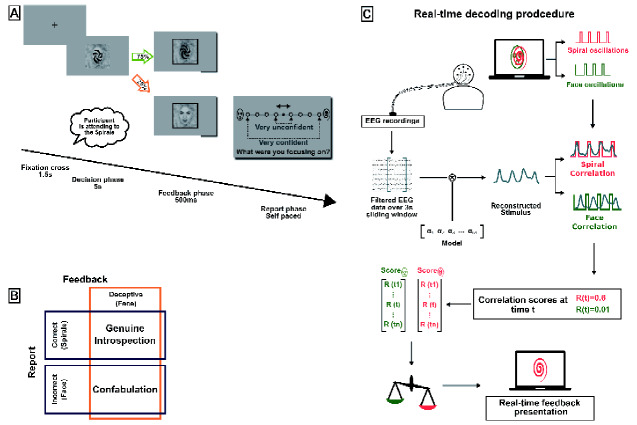
(A) Experimental paradigm. Each trial comprised three phases. (i) Decision phase: participants were presented with overlapping face and spiral oscillating at 1.875 Hz in temporal phase opposition and asked to freely focus on one or the other category. (ii) Feedback phase: participants were then presented with a feedback cue for 500 ms, reflecting their recent decision on 75% of the trials (green, informative trial) or the opposite choice in the 25% remaining trials (orange, deceptive trial). (iii) Report phase: participants were then requested to report the object they preferentially attended just before the feedback cue along with their confidence in this report on a four steps scale. (B) Relationship between report accuracy and introspective accuracy. After deceptive feedback, a correct report corresponds to a genuine introspection while an incorrect report corresponds to a confabulation. However, in the case of informative trials, reports accuracy does not inform on the nature of introspective mechanisms because participants can be correct just by blindly accepting the feedback. (C) Real-time decoding procedure. Each 250 ms, a reconstructed stimulus was computed by linearly combining the 64 EEG electrodes signal over a 3 s window according to the model weights computed beforehand. We then obtain correlation scores for both face (green) and spiral (red) stimuli by computing the correlation between the reconstructed stimulus and the expected face and spiral oscillations respectively. On the end of each trial, correlation scores computed during the last 1.5 s were averaged separately for each category, and the highest average was considered the attended category for the presentation of the feedback cue.